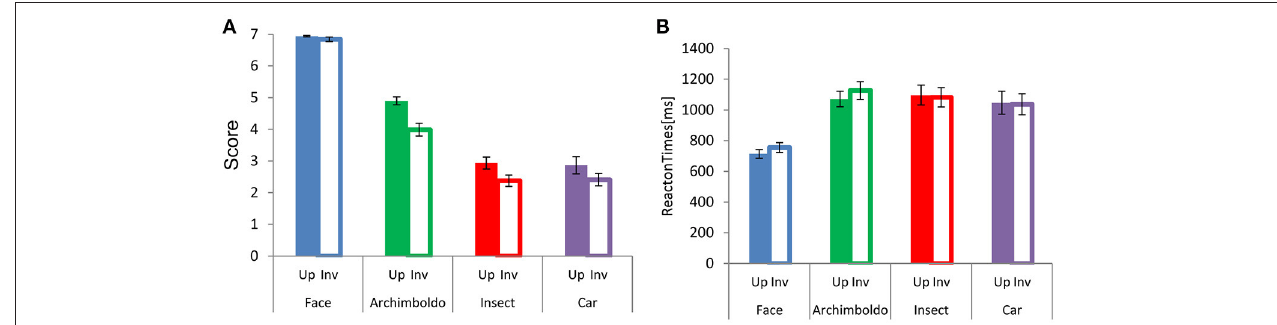
FIGURE 2 | (A) Each bar indicates the mean face-likeness score for each category in the upright (fill) and inverted (no fill) orientations. (B) Each bar indicates the mean reaction times for each category in the upright (fill) and inverted (no fill) orientation.